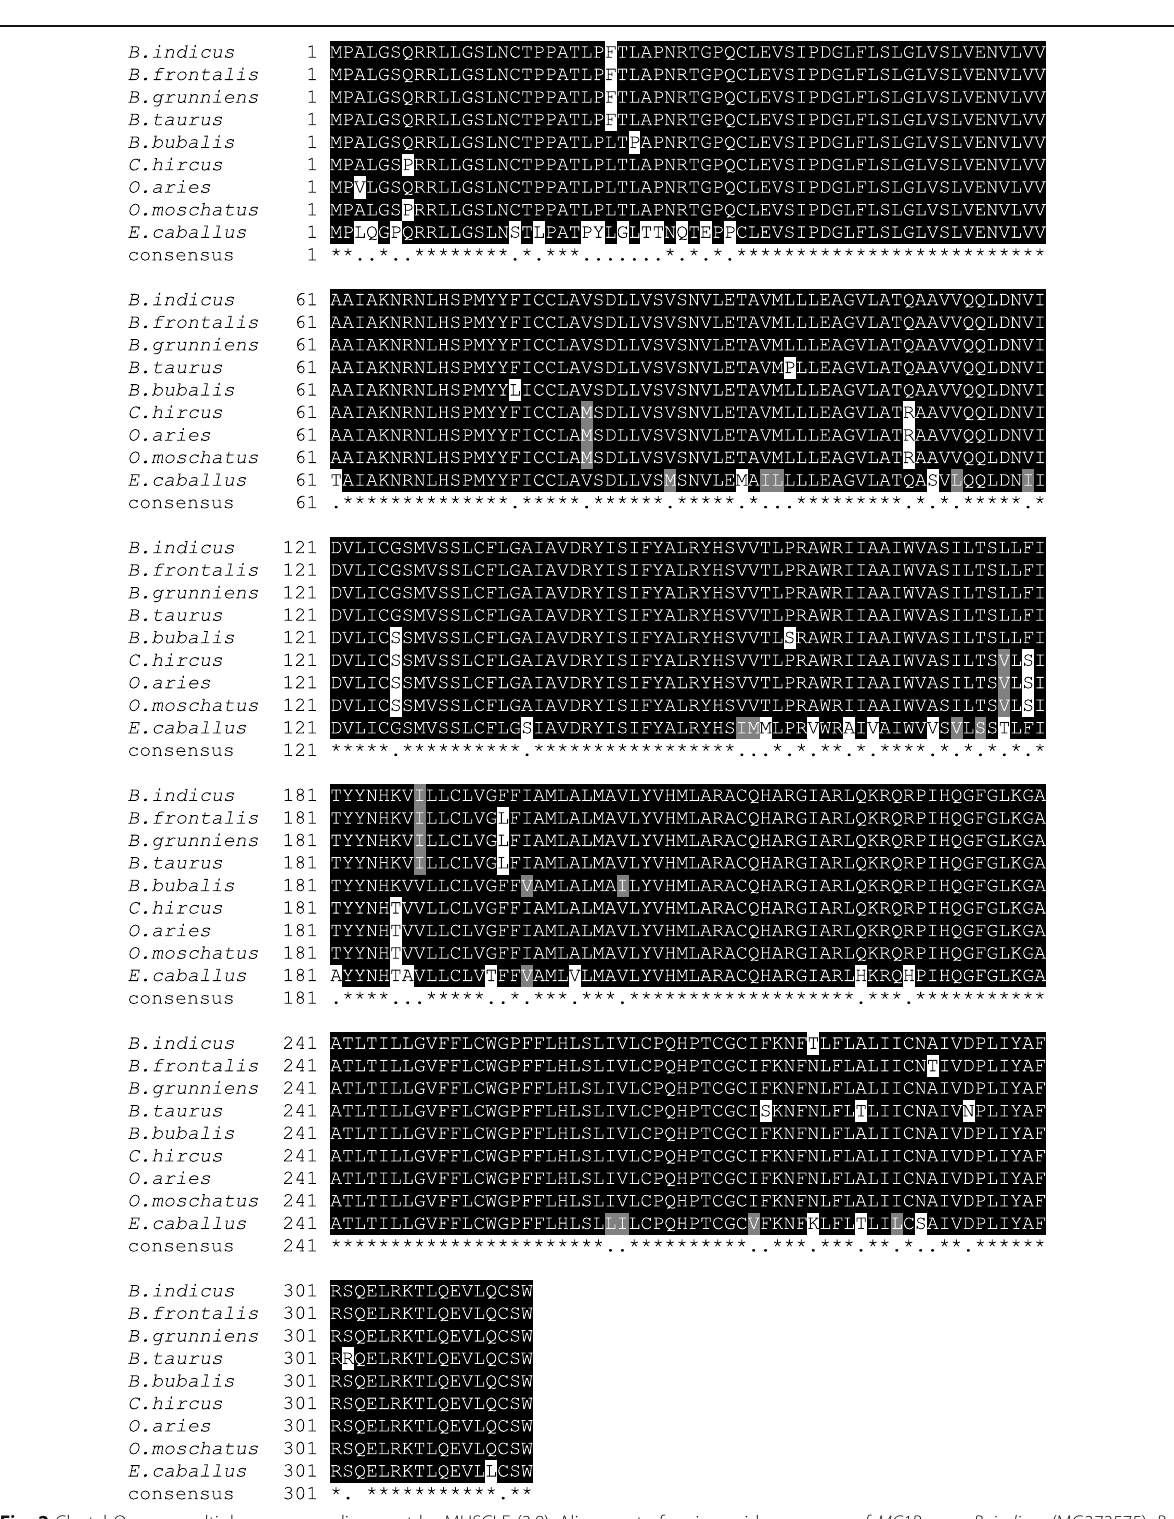
Fig. 2 Clustal Omega multiple sequence alignment by MUSCLE (3.8). Alignment of amino acid sequences of MC1R gene B. indicus (MG373575), B. frontalis (HM488960), B. grunniens (FJ624478), B. taurus (NC037345), B. bubalis (NW020228700), C. hircus (NW017189504), O. aries (NC019471), O. moschats (Y13958), E. caballus (NC009146), illustrates the high identity. The black color region was highly correlated to other mammalian species * a star mark designates a conserved amino acid sequence of the MC1R protein among the all mammalian